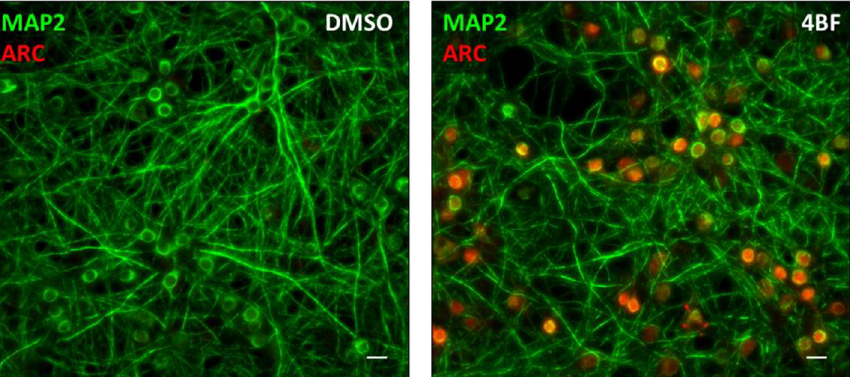
Figure 1. Induction of Arc expression in hippocampal neurons by pharmacological network activation. Hippocampal neurons (DIV19-21) were treated with 4BF , which pharmacologically stimulates network activity and induces LTP of excitatory synapses. After 4 h of enhanced network activity, neurons were fixed and stained for Arc (red) and the neuronal marker Map2 (green). Under vehicle (DMSO) treatment, very little Arc staining could be detected ( left panel, vehicle), whereas the increase in network activity induced strong nuclear Arc expression in approximately half of the neurons: 49 ± 8% ( n = 3) ( right panel, 4BF ) White scale bar is 20 µm.